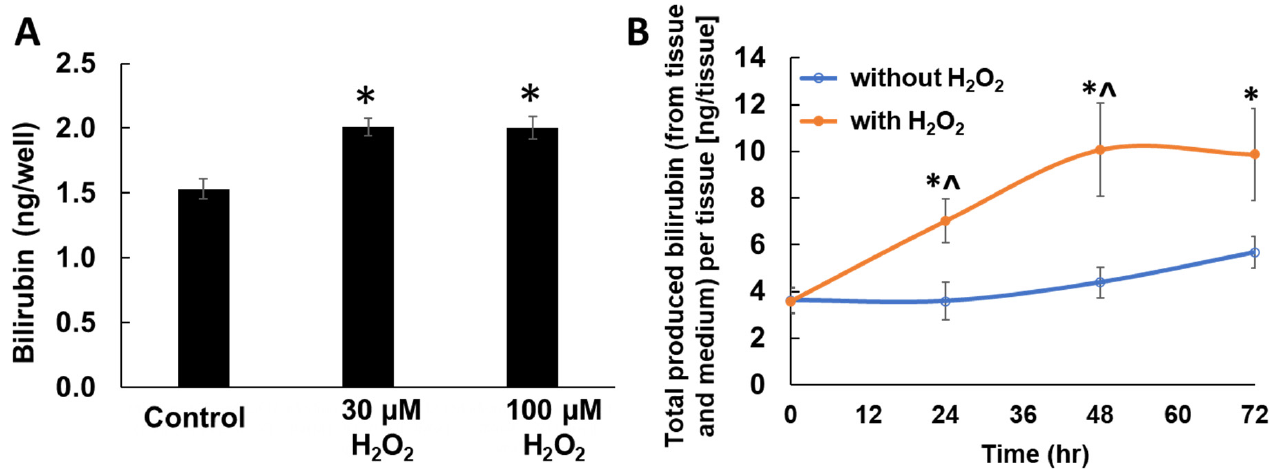
Figure 4. ( A ) Impact of hydrogen peroxide (H 2 O 2 ) treatment (48 h) on de novo bilirubin synthesis in keratinocytes. Bar indicates mean ± SEM. n = 4/group. *; p < 0.05 vs. untreated control. ( B ) Time- course detection of bilirubin in EpiDerm™ 3D human epidermal equivalence cultures (sum of tissue and medium) with and without 30 µM hydrogen peroxide (H 2 O 2 ) in medium for 72 h. Bilirubin was quantified using HPLC-MS method. Data are mean ± SEM. n = 4/group. *; p < 0.05 vs. baseline, ^; p < 0.05 vs. without H 2 O 2 group.